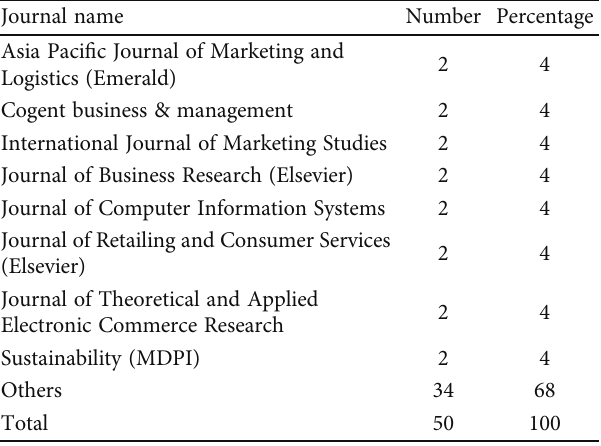
Table 1: List of online consumer behavior studies published journals.